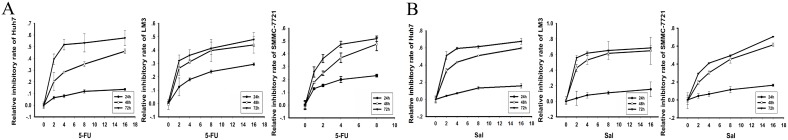
Growth inhibition curves for HCC cell lines Huh7, LM3, and SMMC-7721.5-FU (A) and Sal (B) inhibit HCC cell proliferation. Huh7, LM3, and SMMC-7721 (5×104 cells/ml) were treated with Sal and 5-FU for various times (24, 36, and 48 h). Cell viability was determined using the MTT assay. The data show that Sal and 5-FU exposure reduced Huh7, LM3, and SMMC-7721 cell viability in a dose- and time-dependent manner.